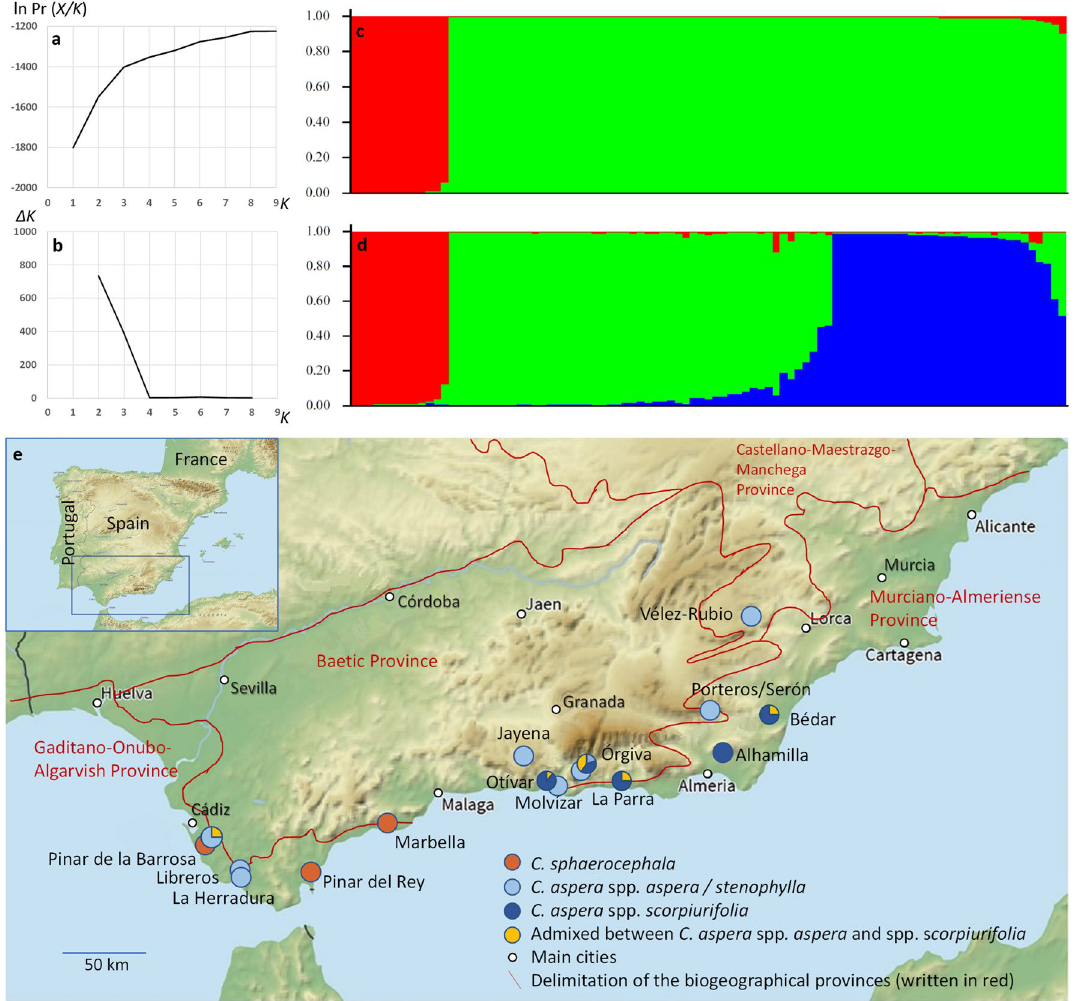
Figure 2. Clustering analysis for 95 Centaurea individuals of the Seridia section in Andalusia using STRU CTU RE. ( a ) log-likelihood of the microsatellite data given K clusters obtained through 20 runs of the algorithm. ( b ) Evanno et al . ’s ∆K statistics. ( c ) Assignment tests for K = 2. Individual plants are represented by vertical bars. Red genetic cluster represents plants identified as C. sphaerocephala , while green cluster represents plants identified as C. aspera . ( d ) Assignment tests for K = 3. Red cluster represents plants identified as C. sphaerocephala , green cluster represents plants identified as C. aspera ssp. scorpiurifolia , and blue cluster those identified as C. aspera ssp. aspera or ssp. stenophylla . ( e ) Genetic constitution of the sampled locations based on STRU CTU RE. Map was downloaded from https:// mapsw ire. com/ (CC-BY 4.0), and modified using Microsoft Paint and Microsoft